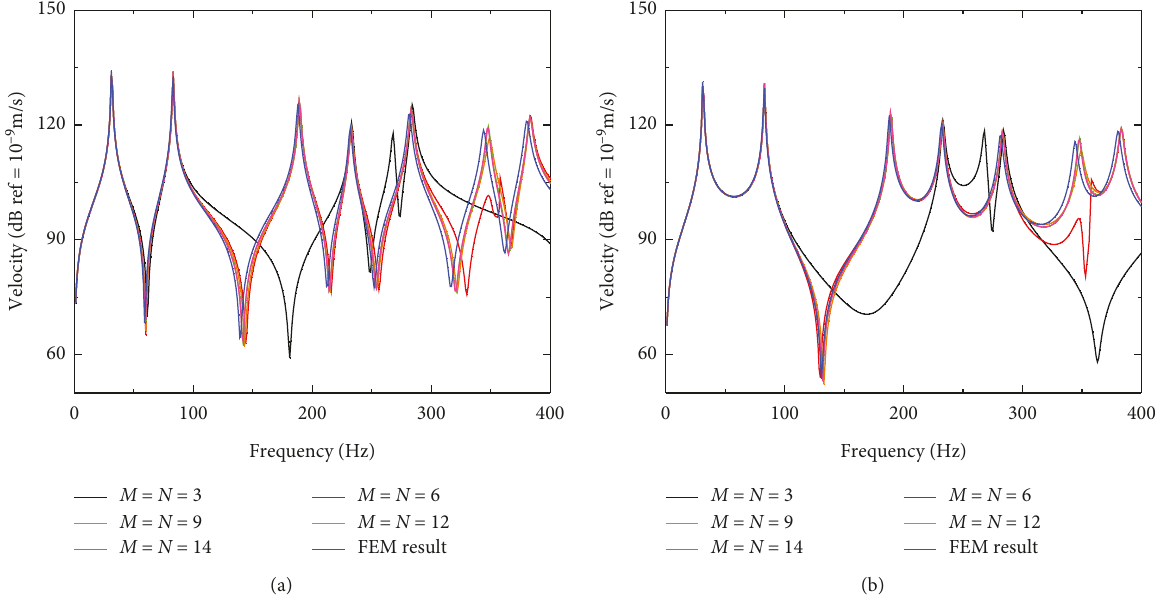
Figure 3: Convergence of velocity response for rectangular plate with one central x -wise beam and one central y -wise beam under unit force ( q w � 1). (a) Point A (1 m, 0.5m). (b) Point B (0.5m, 0.5m).